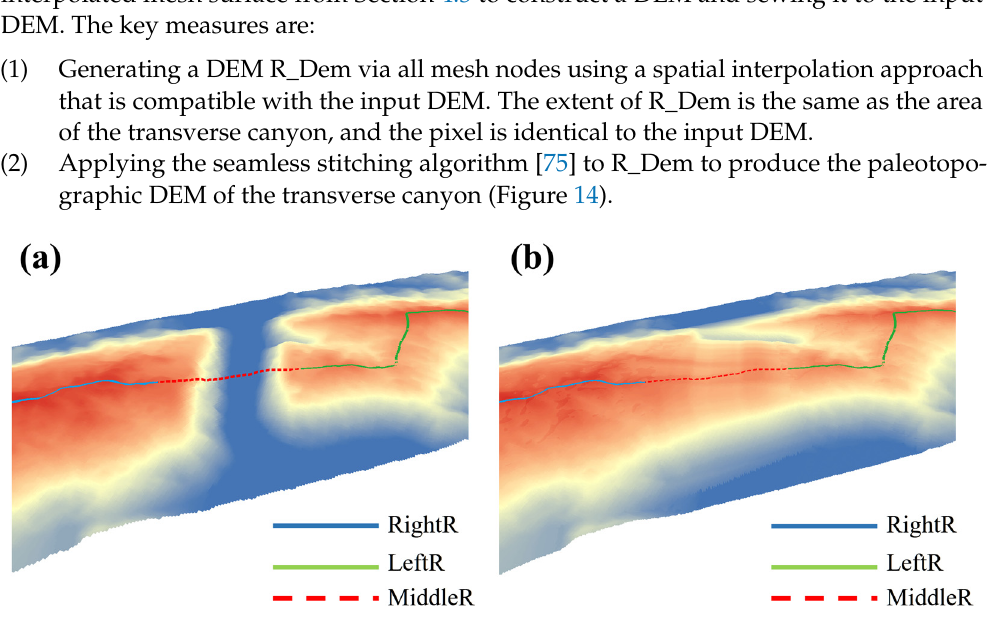
Figure 14. The paleotopographic DEM of C4. ( a ) The present DEM, and ( b ) the reconstructed paleotopographic DEM.